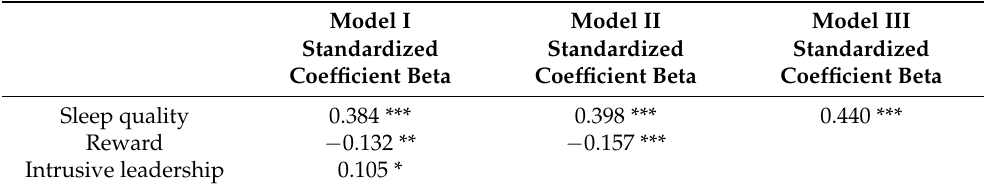
Table 2. Stepwise linear regression models assessing the effect of the individual and occupational variables on the impact of headache on work capacity, measured with the HIT-6